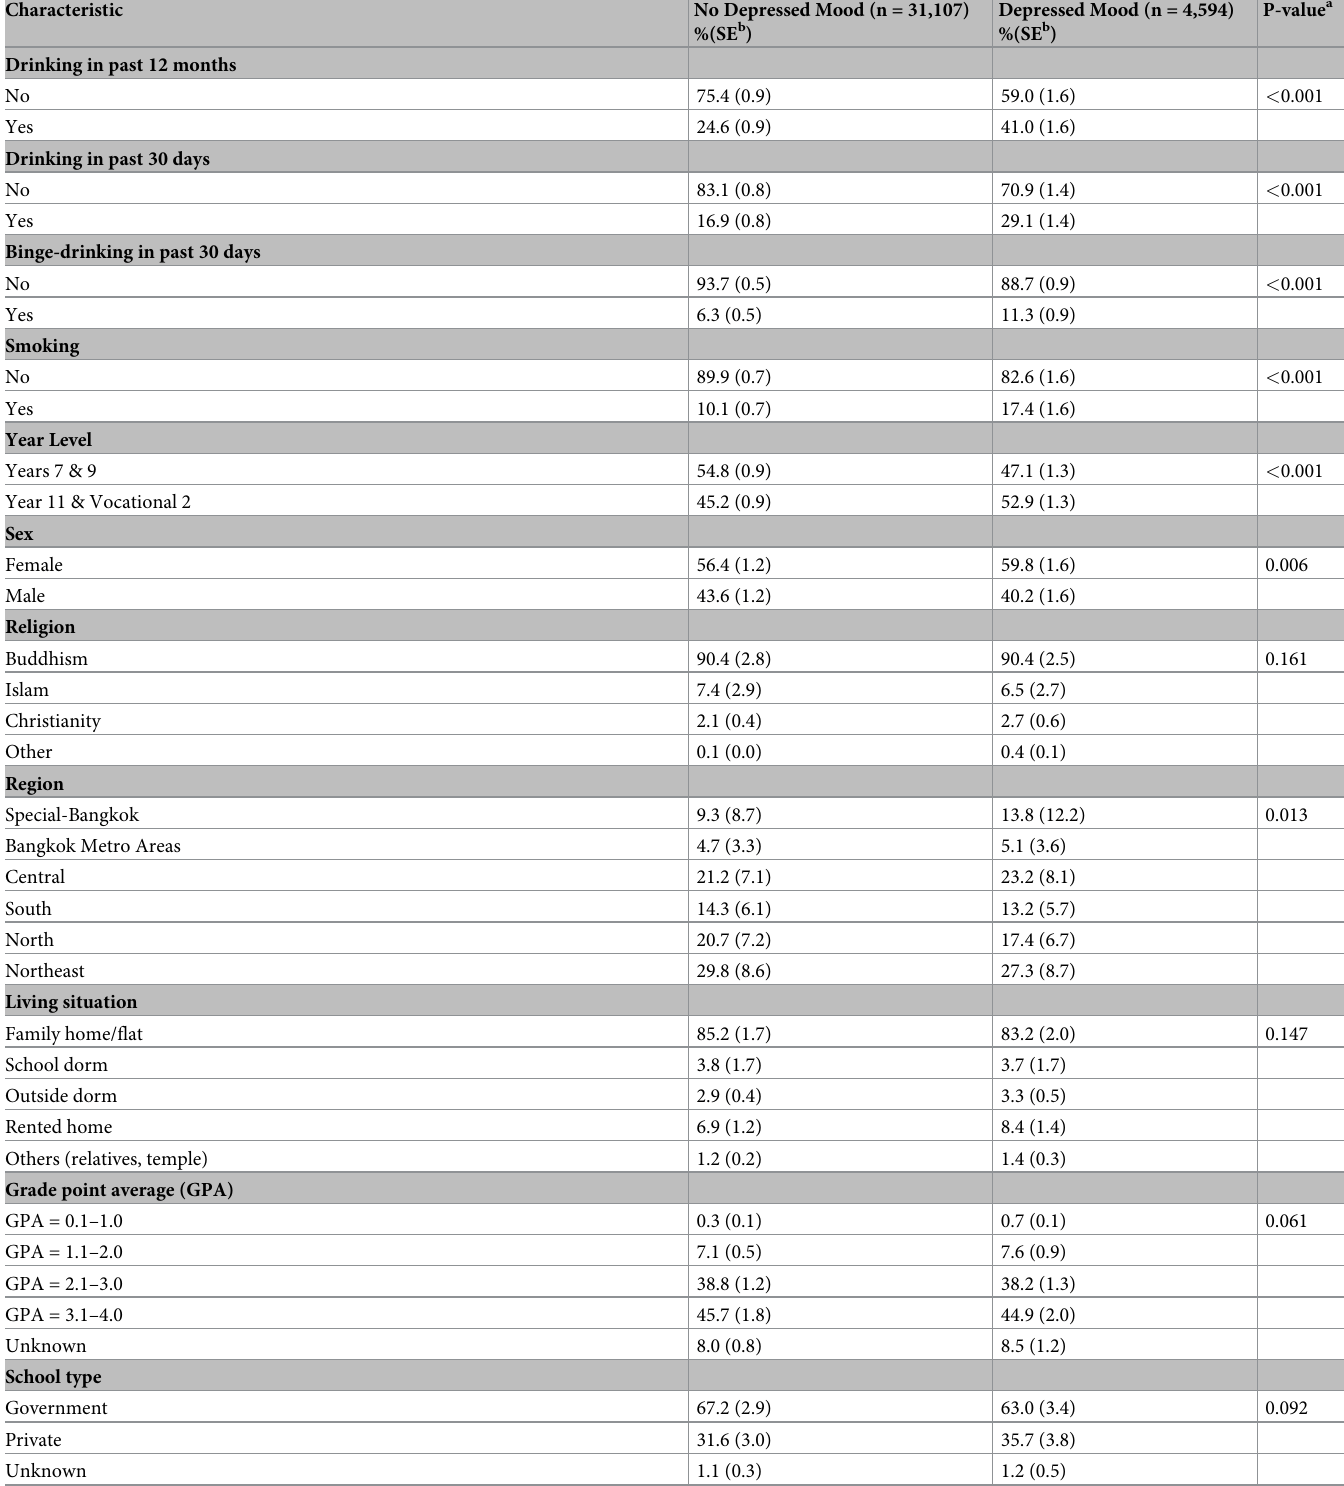
Table 2. Distribution of participants with and without depressed mood by associated